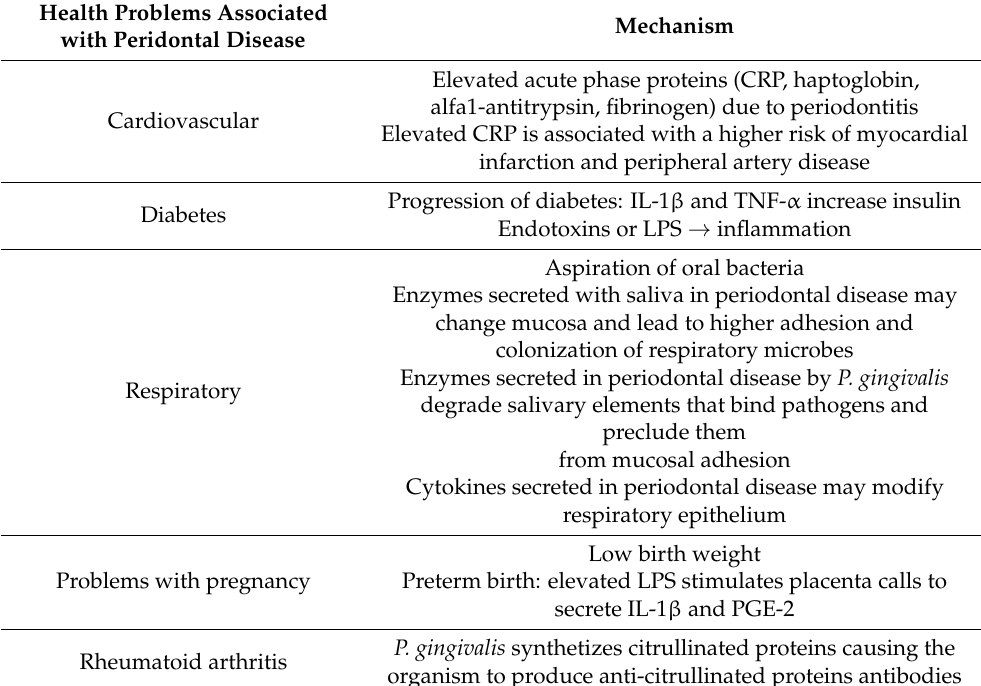
Table 1. Mechanisms of systemic diseases associated with periodontal